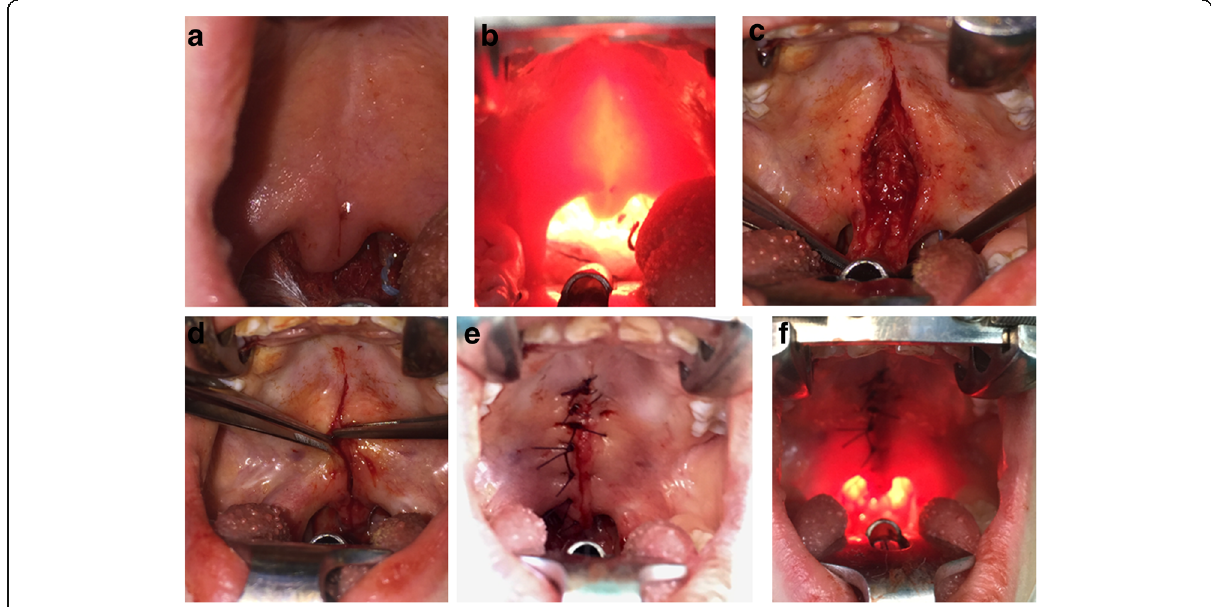
Fig. 1 a Transoral view of bifid uvula and zona pellucida (transparent). b Transnasal transillumination of palate showing bifid uvula and membranous part of palate extending to bony part. c Transoral dissection of central part of palate (intersection of palatal and nasal mucosa) with preservation of nasal mucosa showing muscular part on both side of membranous palate. d Approximation of palate muscle (levator palatini). e Repair of the palatal muscles and mucoperiosteal flaps on the oral side with 3-0 vicryl (simple repair without lateral release incisions). f Post-repair transnasal transillumination of